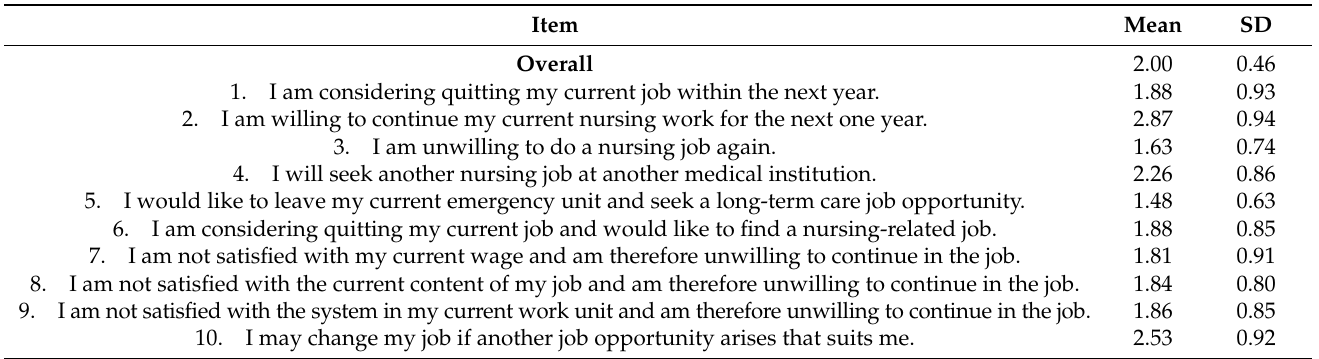
Table 4. Intention to stay in the current position (N =